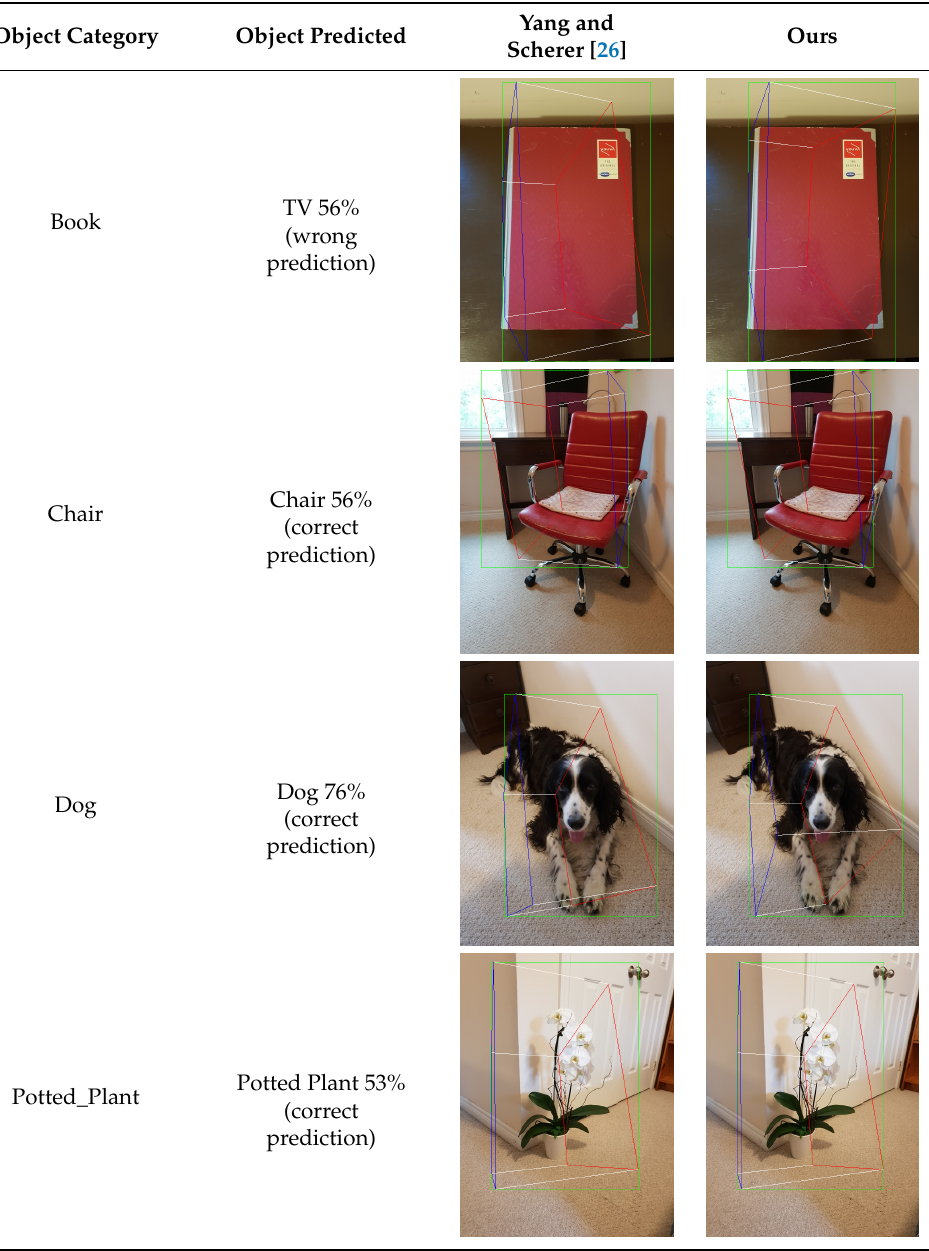
Table 2. Object predicted by SSD-MobileNetV1 (second column from the left) in the image and the corresponding 3D cuboid output using [26] and our